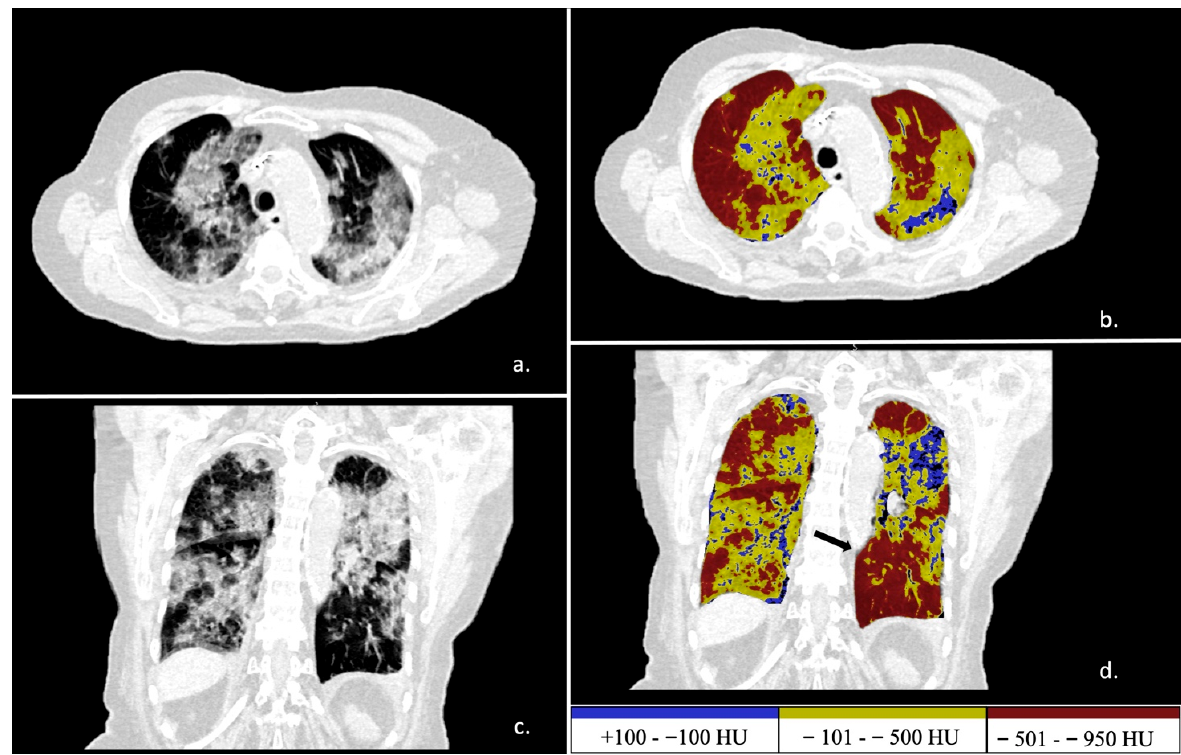
Figure 3. Automatic tissue density analysis. In images ( a , b ), axial views. In images ( c , d ), coronal views. In images ( a , c ), unenhanced CT slices of an extensive lung COVID-19 involvement with bilateral infiltration. In images ( b , d ), the software-dedicated analysis differentiated non-aerated (blue) and poorly aerated (yellow) tissue. In red, well-aerated lung tissue. In image ( d ), the black arrow indicates the exclusion of Hilary structure from high-density tissue. Color bar values on the bottom